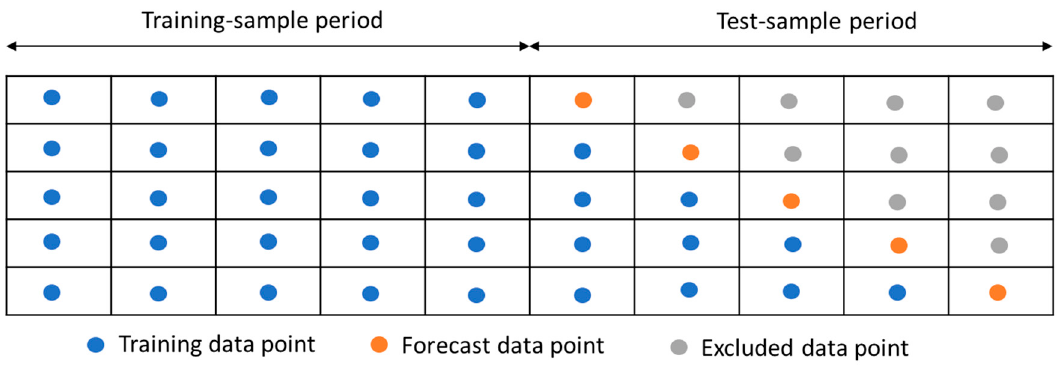
Figure 3. Illustration of static forecast approach. Table 2. Training-sample forecast performance.